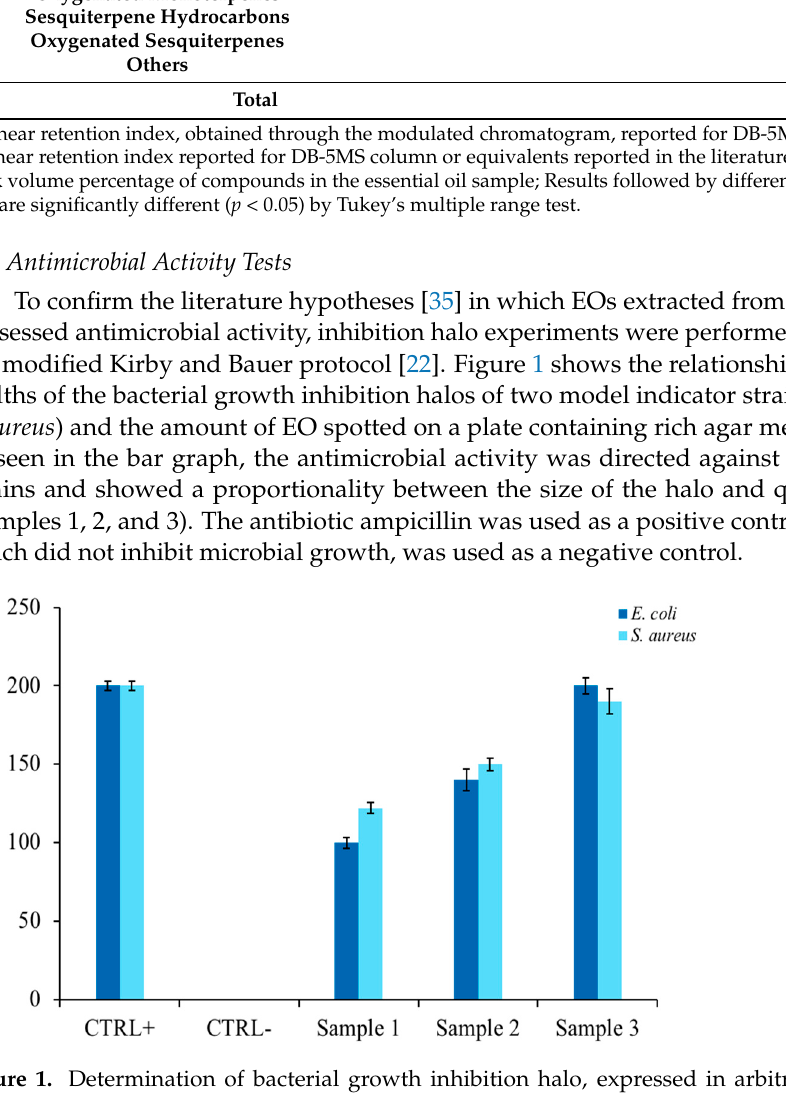
Figure 1. Determination of bacterial growth inhibition halo, expressed in arbitrary units. The histogram represents the zone of inhibition, expressed in AU/mL, of C. aurantium ‘Crispifolia’ against E. coli and S. aureus . Samples 1, 2, and 3 represent 1, 10, and 50 µL of C. aurantium ‘Crispifolia’ EO, respectively. Positive control is ampicillin, negative control is DMSO (40%). The values are expressed as means of three different experiments; standard deviations are always less than 10%.